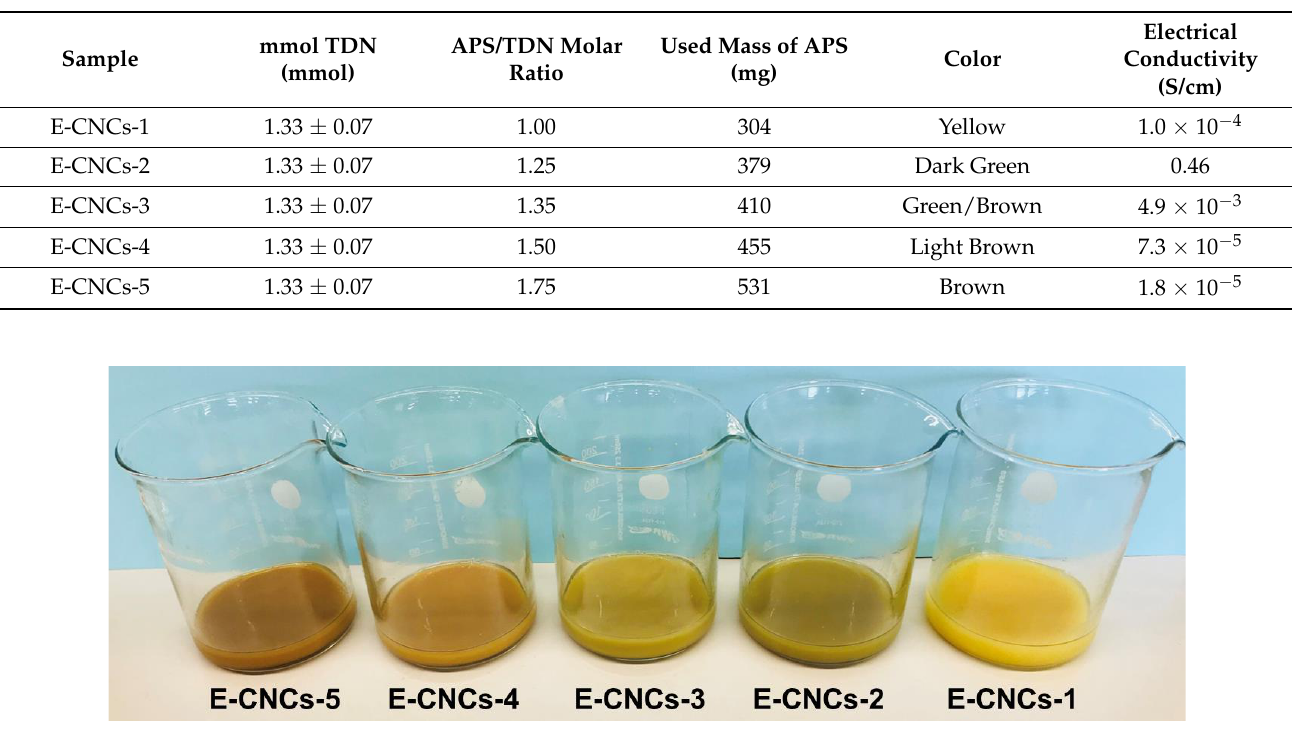
Figure 8. The colors of the E-CNCs after polymerization using different amounts of APS showing the different chromic forms of the conductive shell.